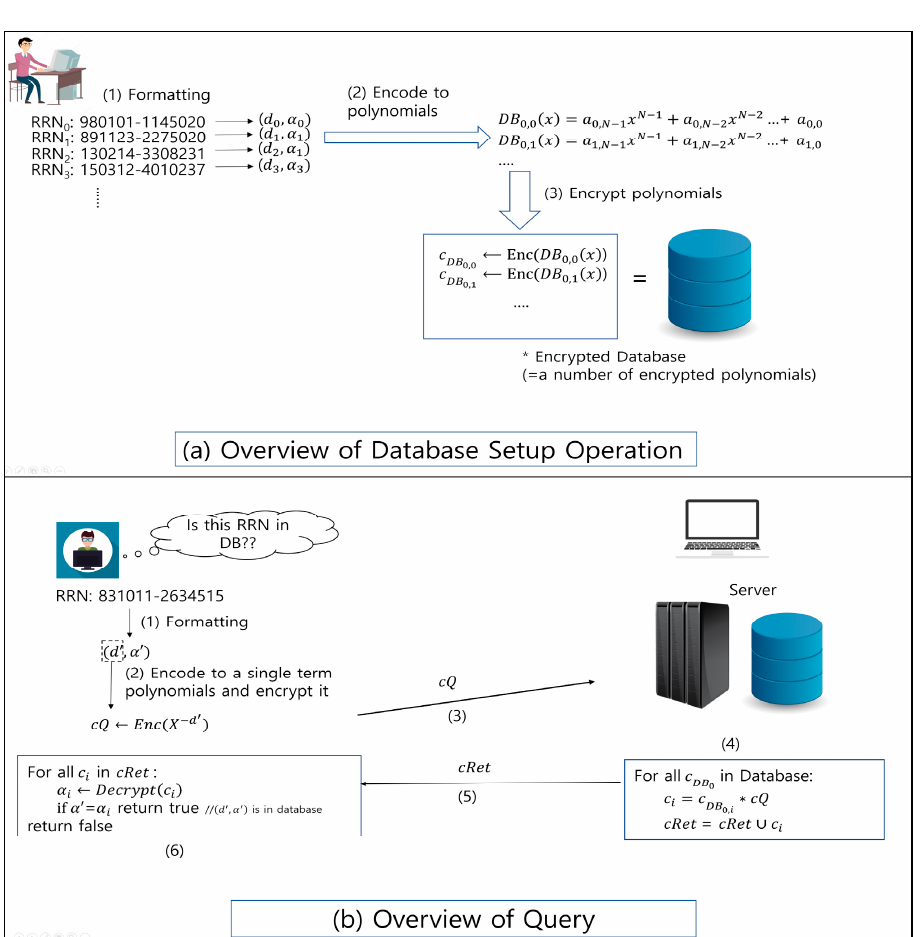
Figure 3. Overview of the proposed scheme.